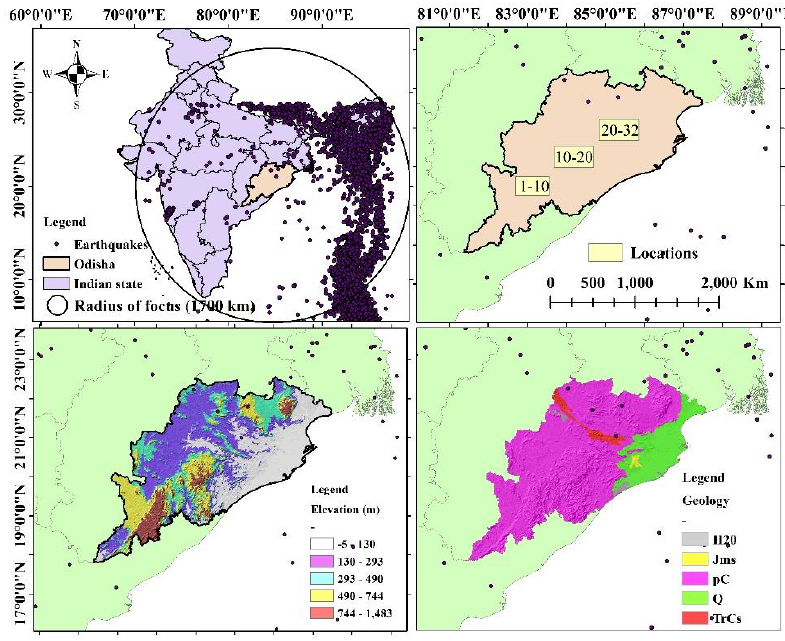
Figure 1. Study area location (H 2 O: water, Pc: pre-cambrian, Q: quaternary, TrCs: Triassic and cretaceous, and Jms: Jurassic rocks and deposits).